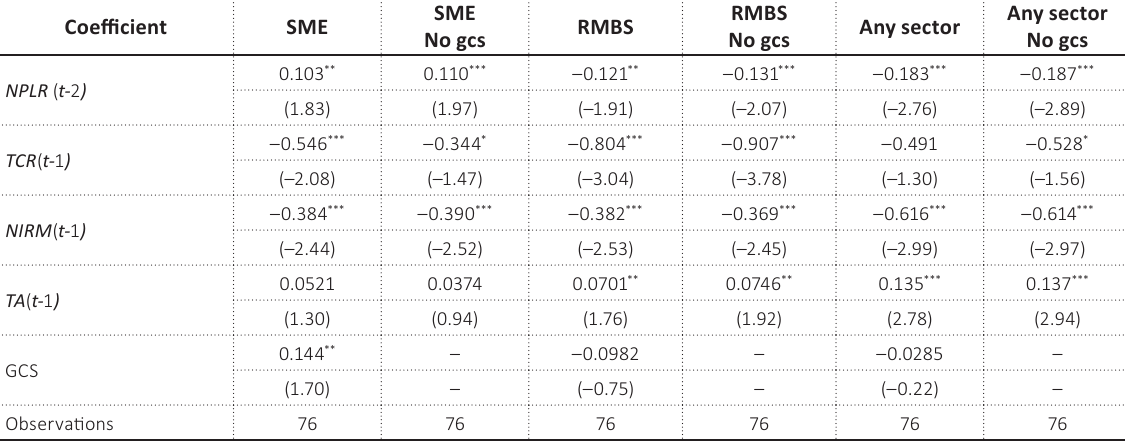
Table A7. Pooled logit estimation (t-statistics in